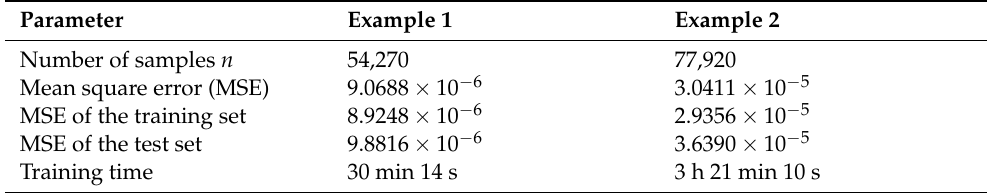
Table 4. Statistics of training